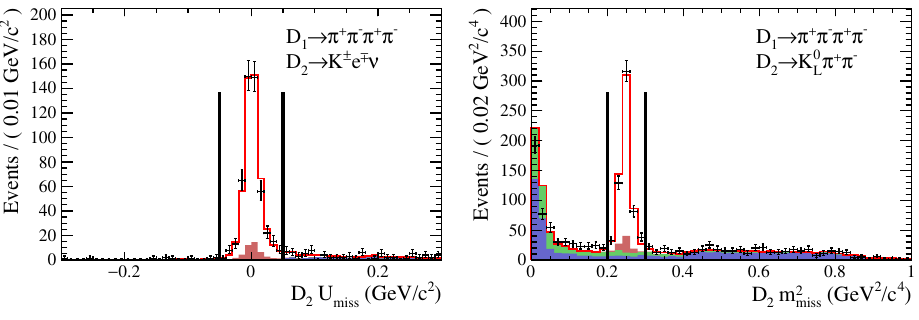
Figure 6 . Distribution of U miss ( m 2 ) for selected double tags containing a neutrino ( K 0 ). Su- miss L perimposed is the result of an unbinned maximum likelihood (cid:12)t that is described in the text. The blue/green/red shaded area shows the distribution of combinatoric/continuum/peaking background respectively. The red line shows the total signal + background PDF. The black vertical lines indicate the events that fall within the signal region that are used for further